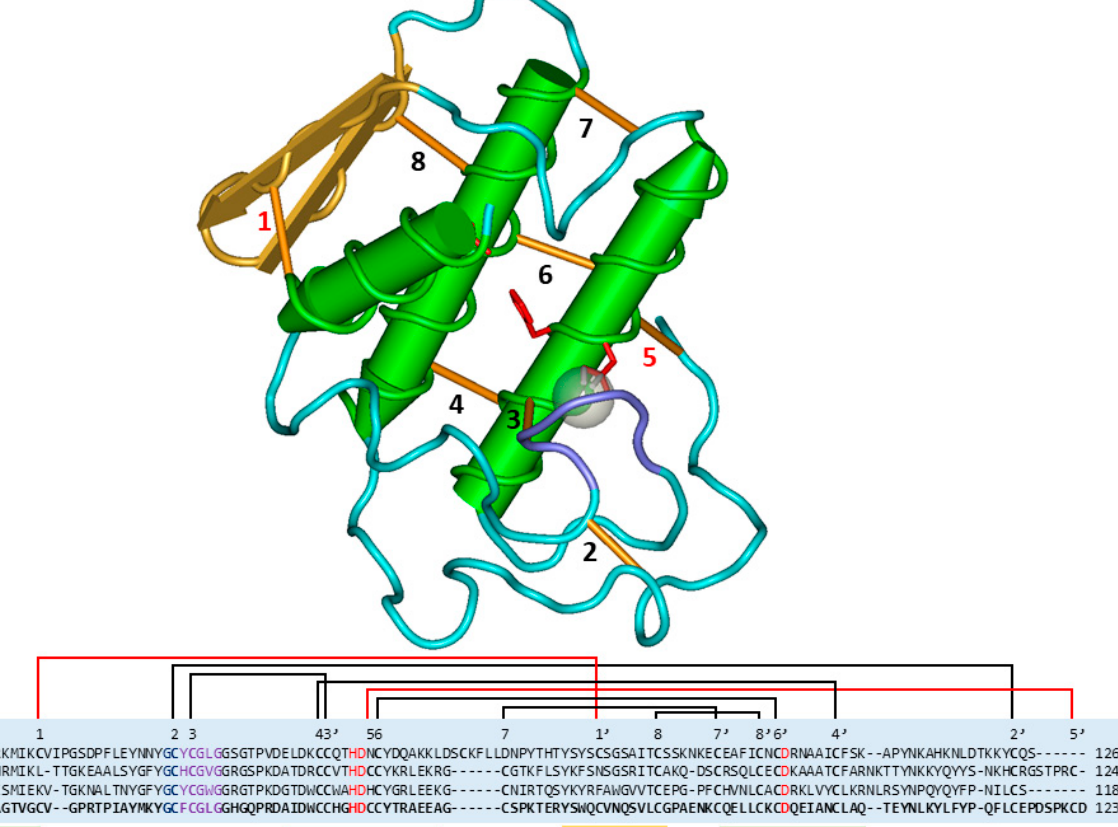
Figure 1. Structure of human sPLA2 of group X and sequence alignment of this with human sPLA2s of the groups IB, IIA, and V. The different sPLA groups are distinguished by the number and position of the disulphide bridges. In the sequence alignment, the conserved bridges in all conventional sPLA2s are shown in black, the active site residues in red, and the calcium binding loop residues in purple. Group X sPLA2s possess eight disulphide bridges, numbered from 1 to 8 according to the order of appearance in the sequence of the first cysteine in the bridge. Group I and group II sPLA2s possess seven bridges, whose cysteines are aligned with those of bridges 1–7 and 2–8 of group X sPLA2, respectively. In contrast, group V sPLA2s have six bridges, whose cysteines are aligned with those of bridges 2–7 of group X sPLA2. The three-dimensional structure representation was obtained from the protein data bank (PDB), file 1LE7, using the Cn3D macromolecular structure viewer.